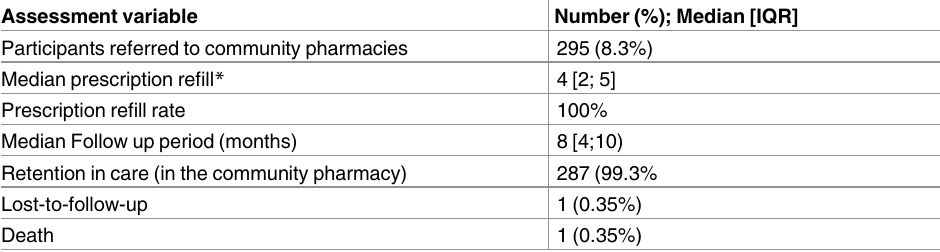
Table 2. Overall outcome of the pilot study within the review period.